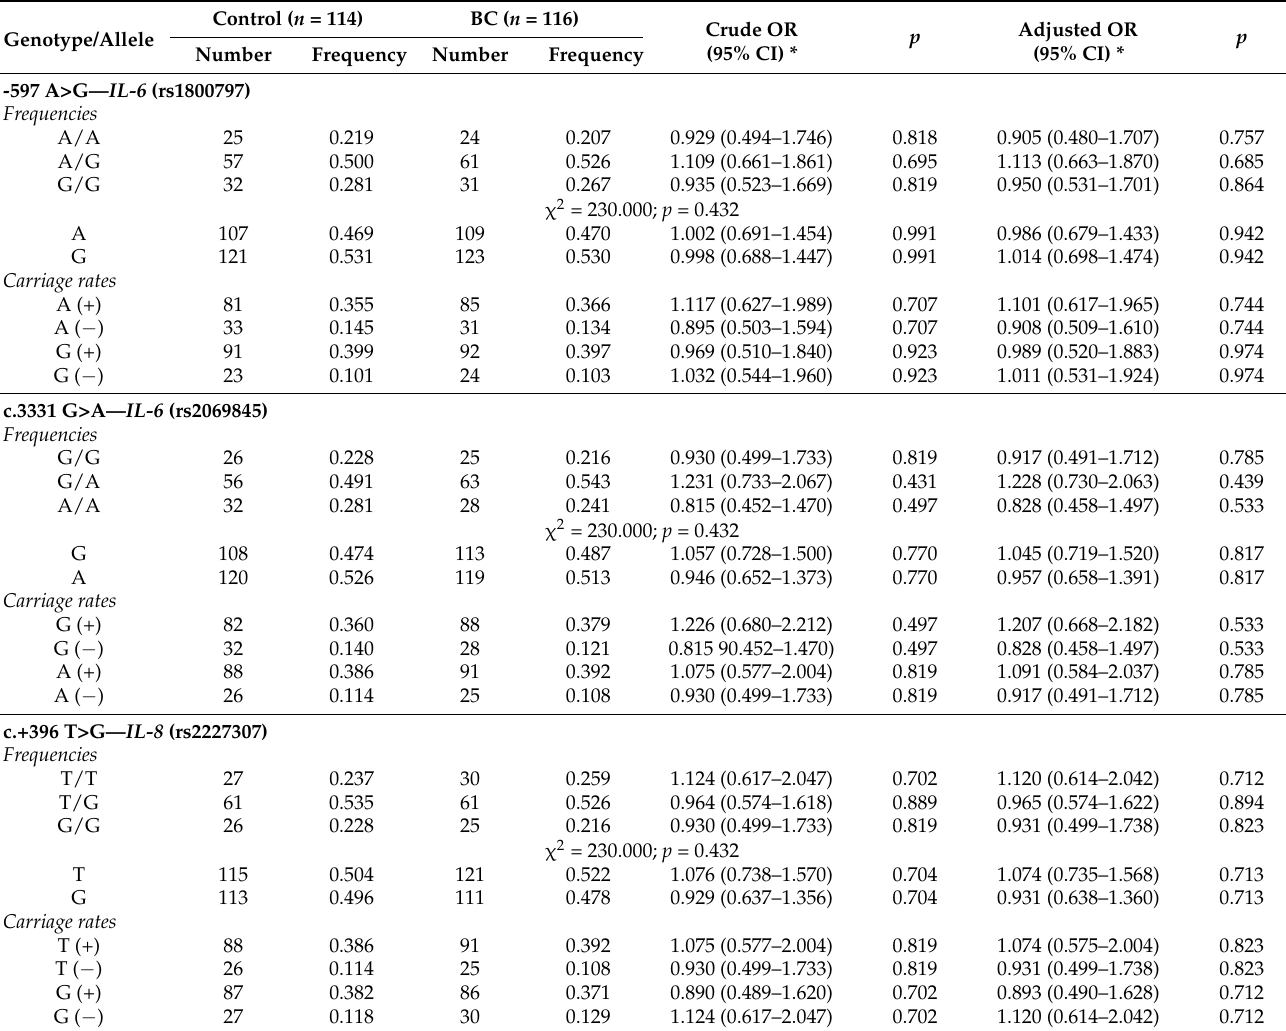
Table 2. Distribution of genotypes and alleles of the 597 A>G— IL-6 (rs1800797), c.3331 G>A— IL-6 (rs2069845), and c.+396 T>G— IL-8 (rs2227307) polymorphisms and odds ratios (ORs) with